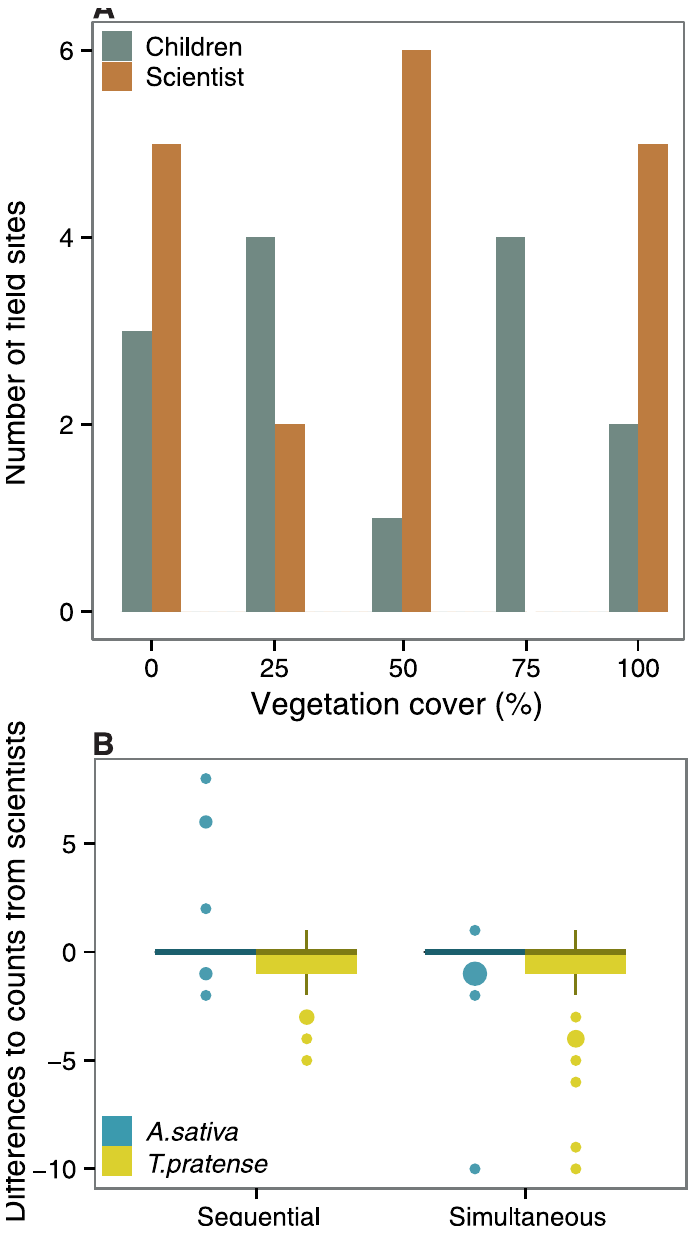
Fig 2. Comparison between estimated vegetation cover and seed count data between children and scientists. Bar plots in (A) show the number of field sites at which the different cover categories (in %) were recorded. Box plots in (B) show the differences of the children ’ s counts (in sequential and simultaneous groups) compared to seed counts by scientists. The size of the outliers reflects the number of data